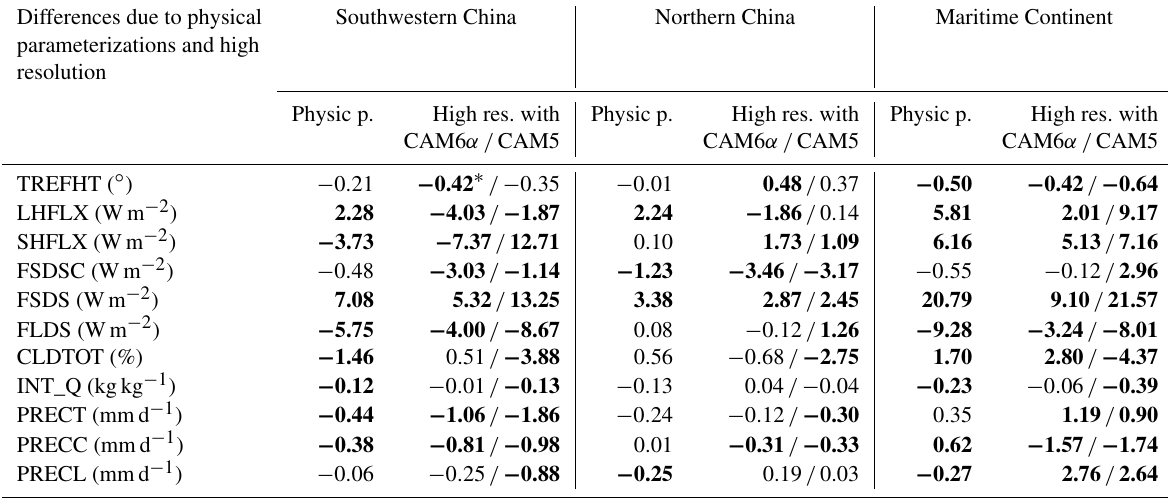
Table 2. Simulation differences due to physical parameterizations (CAM6 α -1 ◦ minus CAM5-1 ◦ ) and high horizontal resolution (CAM6 α